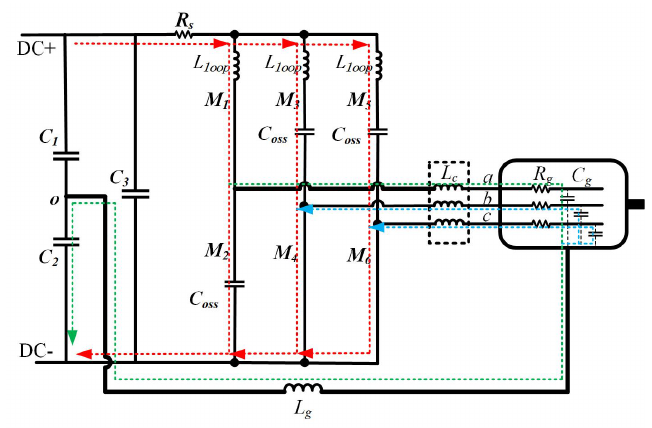
Figure 14. DM propagation path of the HF components in motor drives.